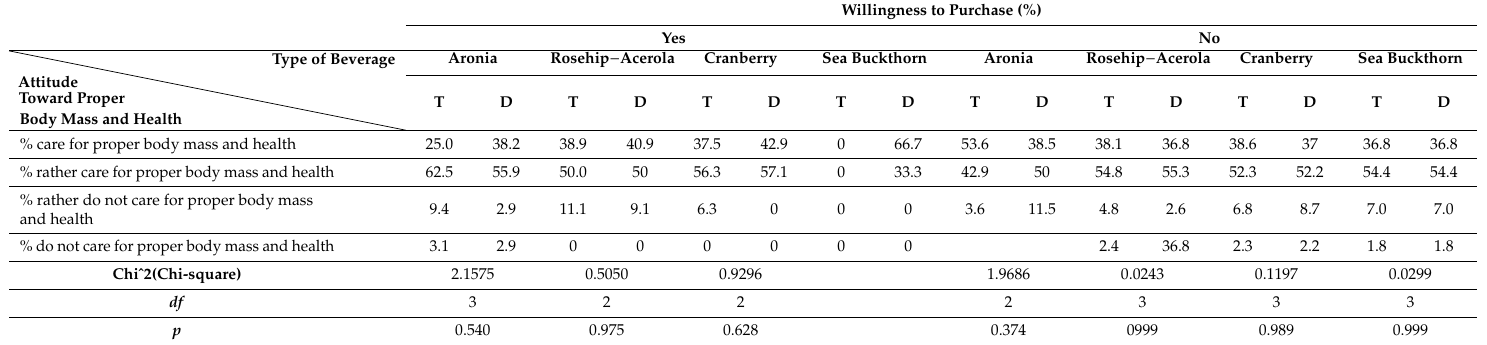
Table 7. Consumer willingness to purchase beverages depending on care for proper body weight and